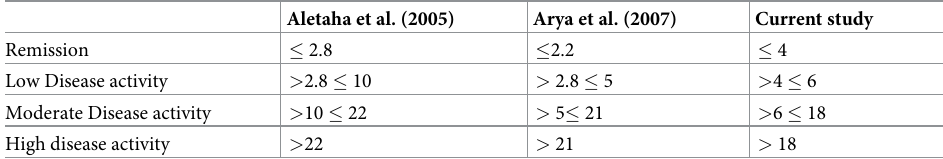
Table 4. CDAI cut-off values derived from different